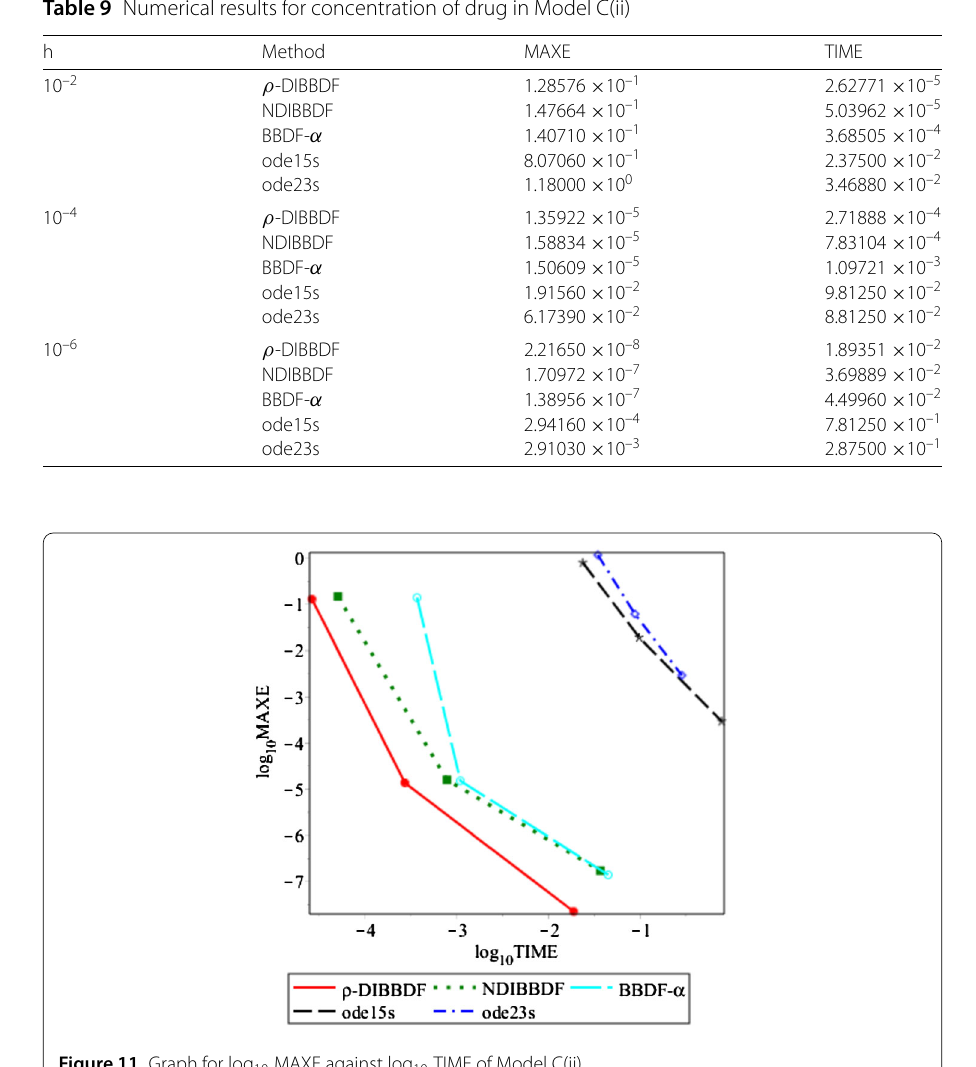
Figure 11 Graph for log 10 MAXE against log 10 TIME of Model